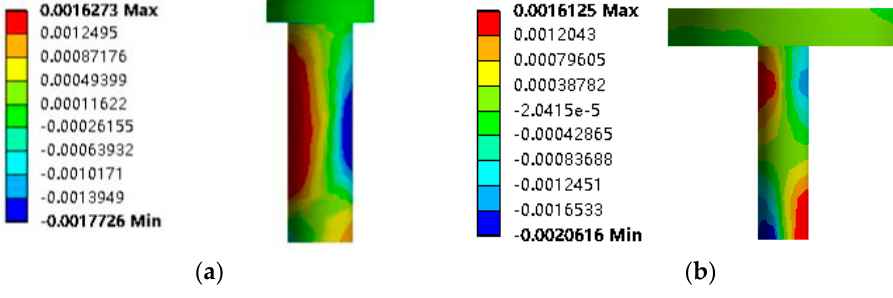
Figure 14. Axial strain of the studs at Section 2-2 ( με ). ( a ) CSB-1. ( b ) CSB-2.